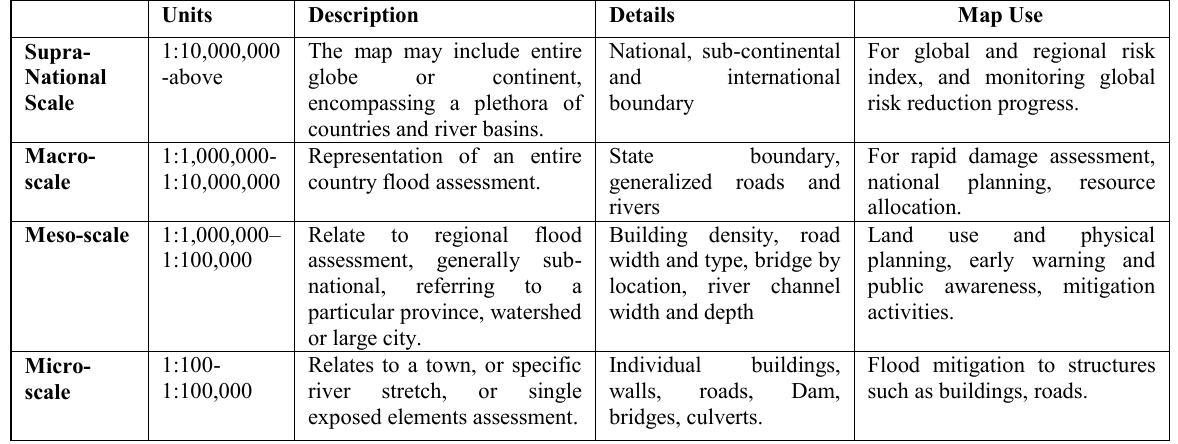
Table 1: Different spatial scales for flood risk and